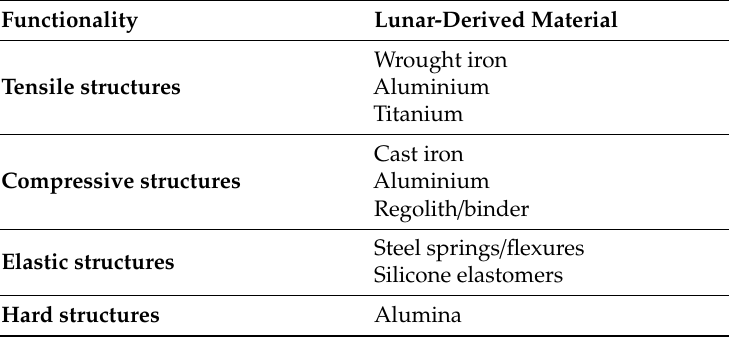
Table 3. Lunar demandite for constructing robotic